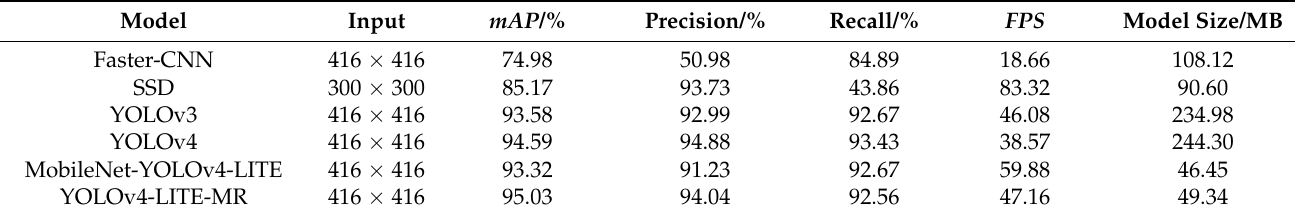
Table 7. Comparison of performance of different models.